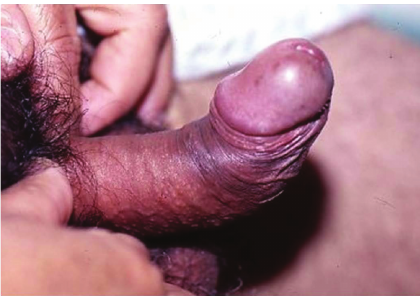
Figure 2: Correction of Peyronie’s with corporeal